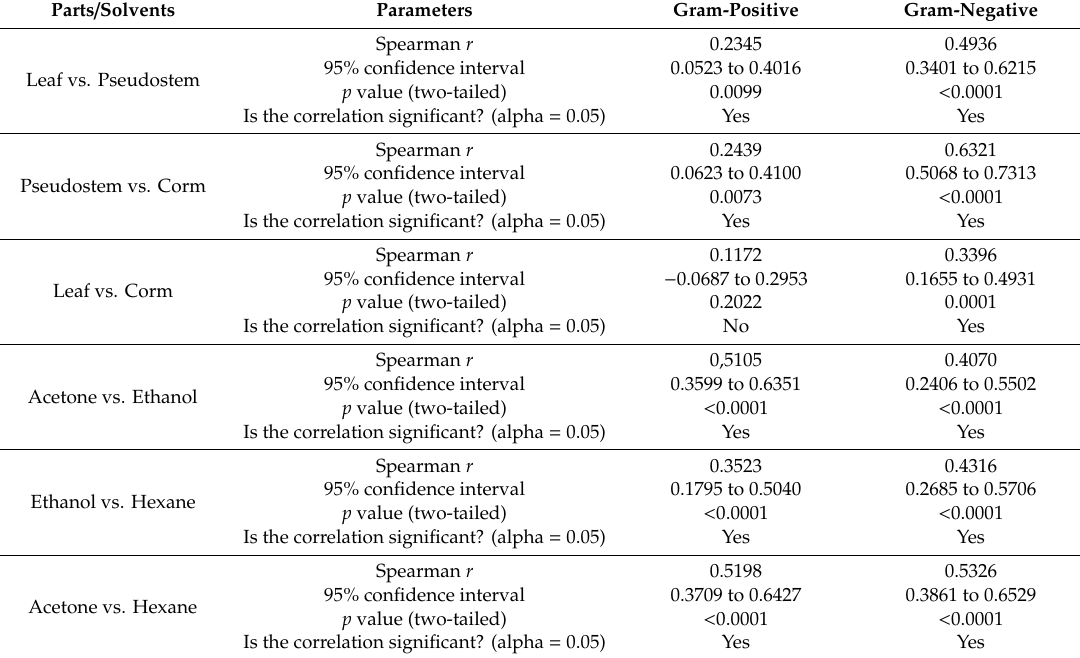
Table 3. Calculation of nonparametric correlation (Spearman r ) between different plant parts and